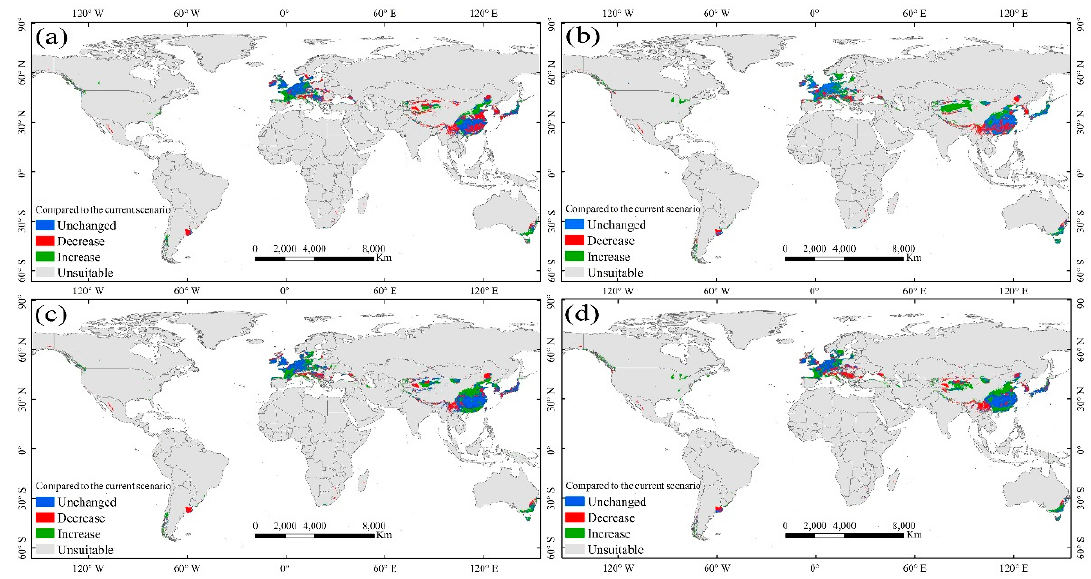
Figure 6. Trends in the habitat suitability of M. glyptostroboides under future climate scenarios (compared to the present day): ( a ) Under RCP4.5 in the 2050s, ( b ) under RCP8.5 in the 2050s, ( c ) under RCP4.5 in the 2070s, and ( d ) under RCP8.5 in the 2070s. The blue, red, and green represent the habitat suitability remaining unchanged, deceasing, and increasing, respectively. Table 2. Statistics of the habitat suitability change in M. glyptostroboides in the future, which is expressed as the percentage of the habitat area with different trends in the total suitable area. The units are %.